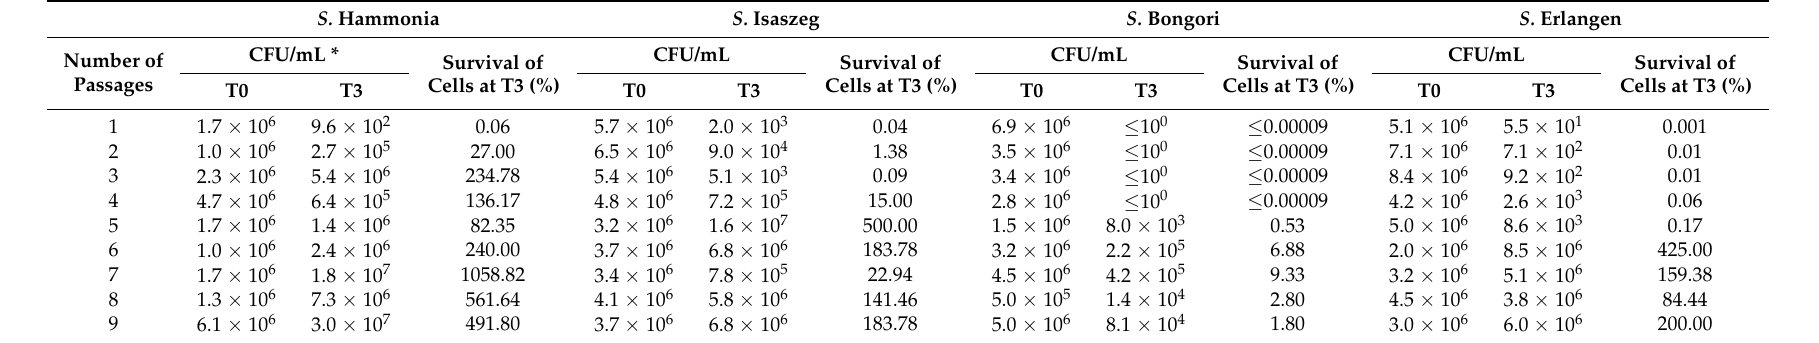
* CFU/mL—colony-forming units in milliliter; NHS: normal human serum. Table 2. Bactericidal activity of 50% NHS decomplemented by heating at 56 ◦ C for 30 min against Salmonella O48 strains.